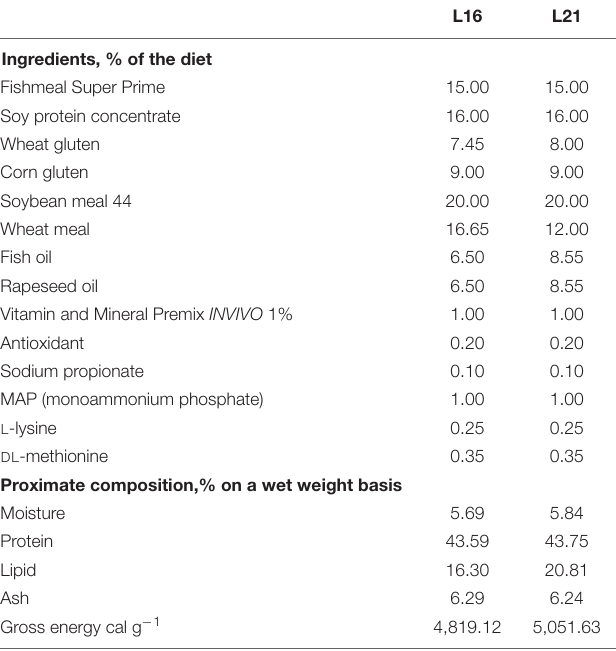
TABLE 1 | Ingredients and proximate composition of the experimental